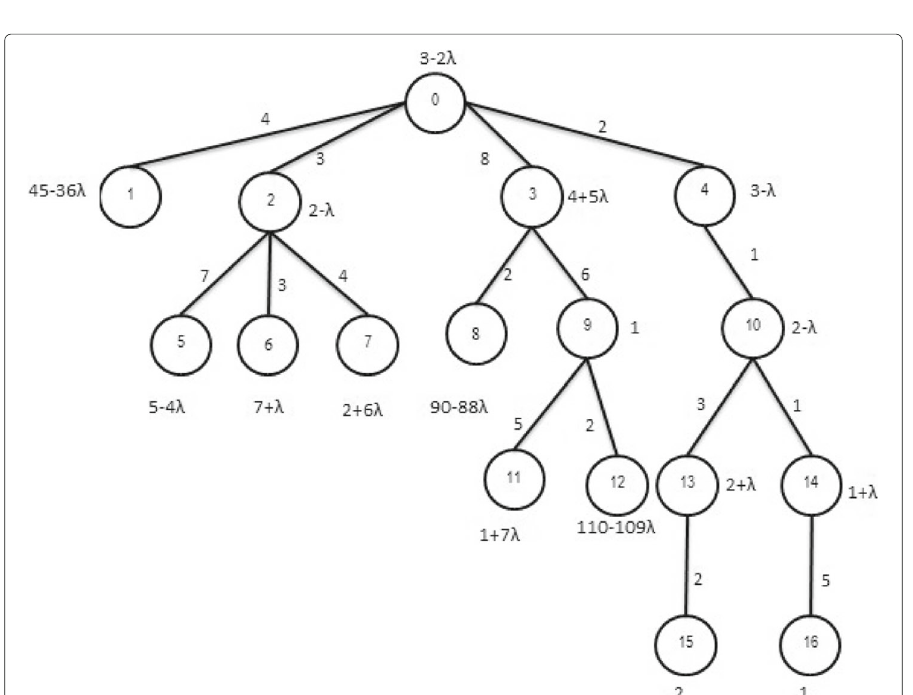
Fig. 6 Convex combination of weights of two